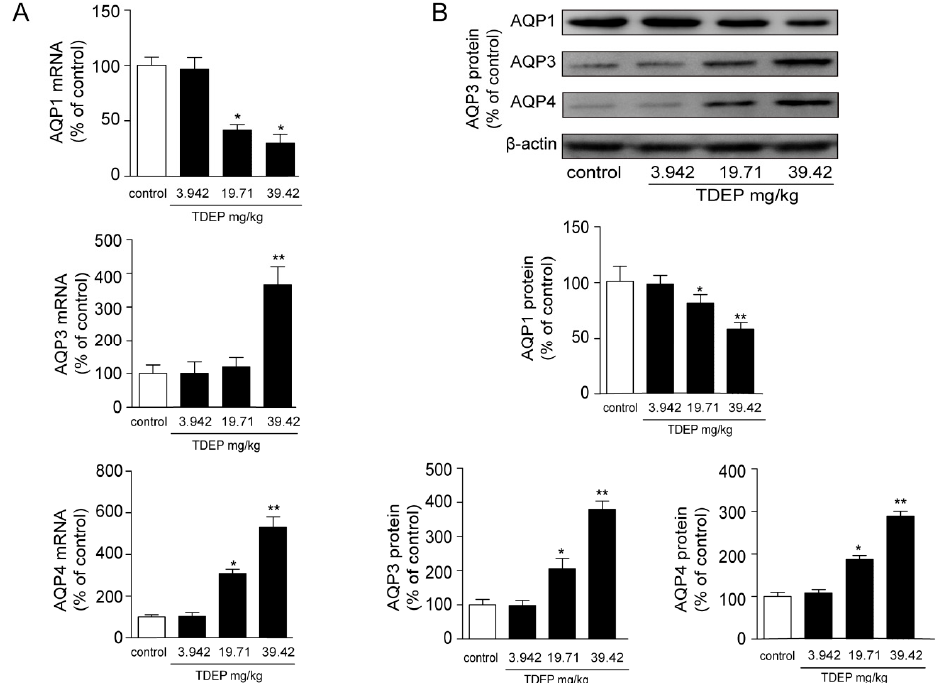
Figure 4. Changes in mRNA expression levels ( A ) and protein expression levels ( B ) of AQPs in the mice colon after the administration of TDEPs; ( A ) Expression level of AQP3 mRNA in mice colons treated by TDEP at different dosages (3.942, 19.71 and 39.42 mg/kg, respectively) for 3 h. The results were normalized with β -actin level and AQPs mRNA level of the control was taken as 100%; ( B ) Expression level of AQPs protein in mice colons treated by TDEP at different dosages (3.942, 19.71 and 39.42 mg/kg, respectively) for 3 h. The results were normalized with β -actin protein level, and all AQPs protein level of the control was taken as 100%. Data are represented as the mean ± SD. * p < 0.05, ** p < 0.01 vs. control group, respectively. n = 3 in each group and each assay was repeated six times.